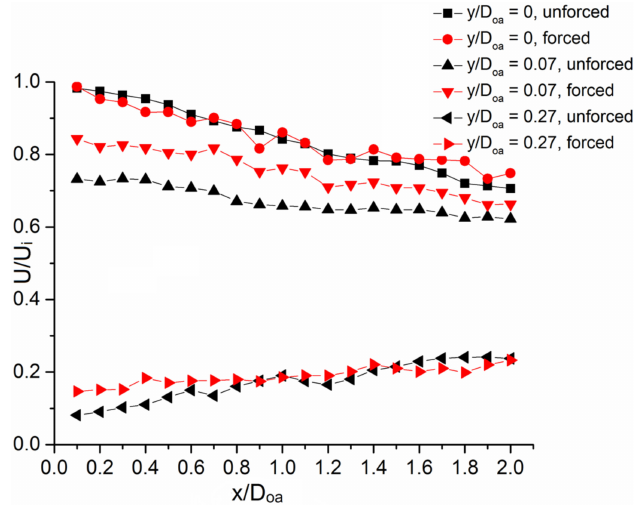
Figure 3. Velocity distribution along axial direction at different sections of nozzle A.